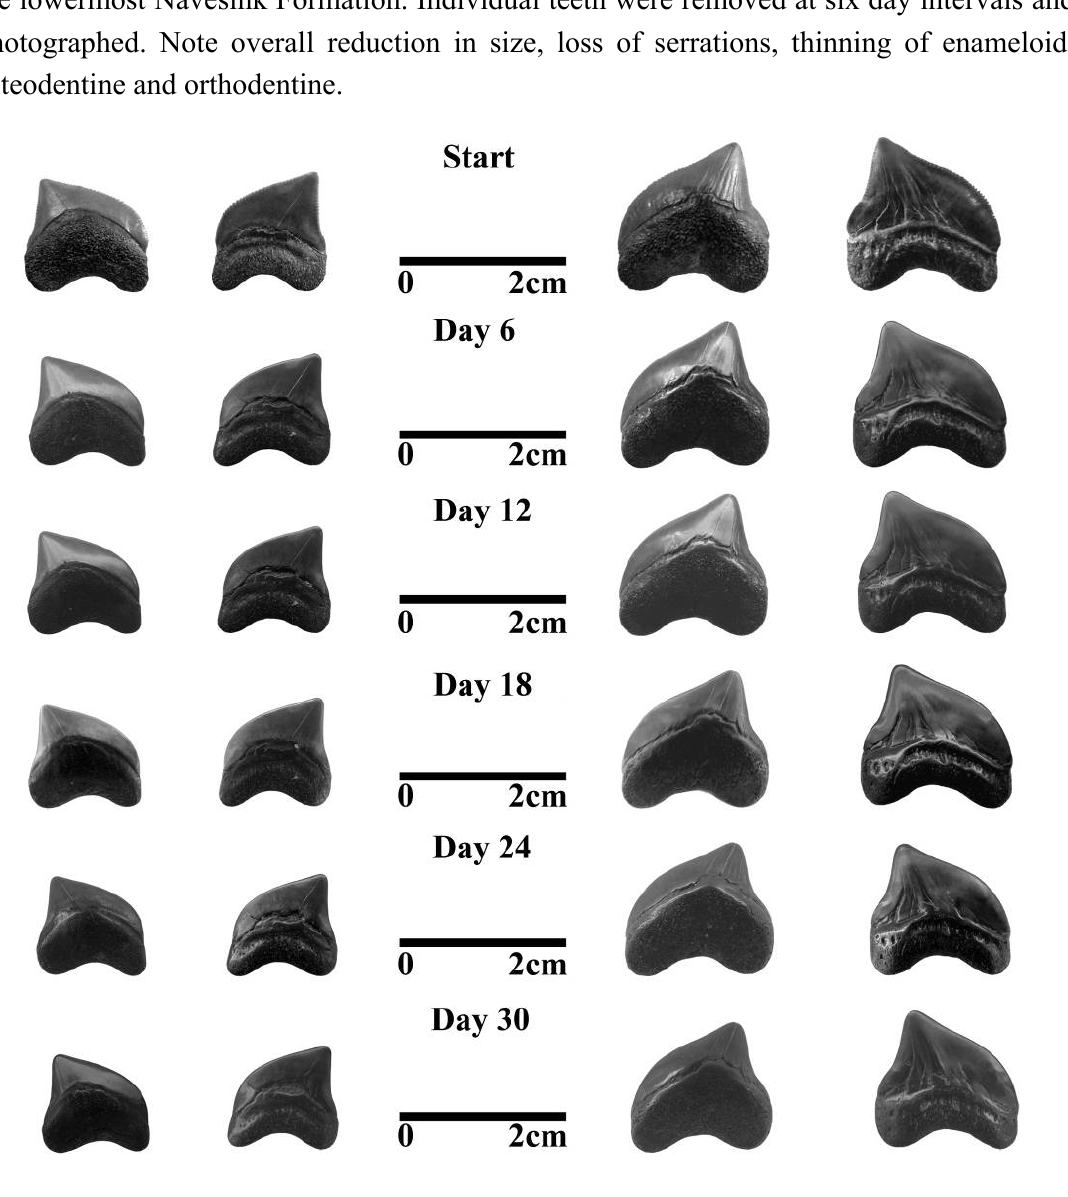
Figure 5. Squalicorax kaupi and Squalicorax pristodontus functional teeth (lingual